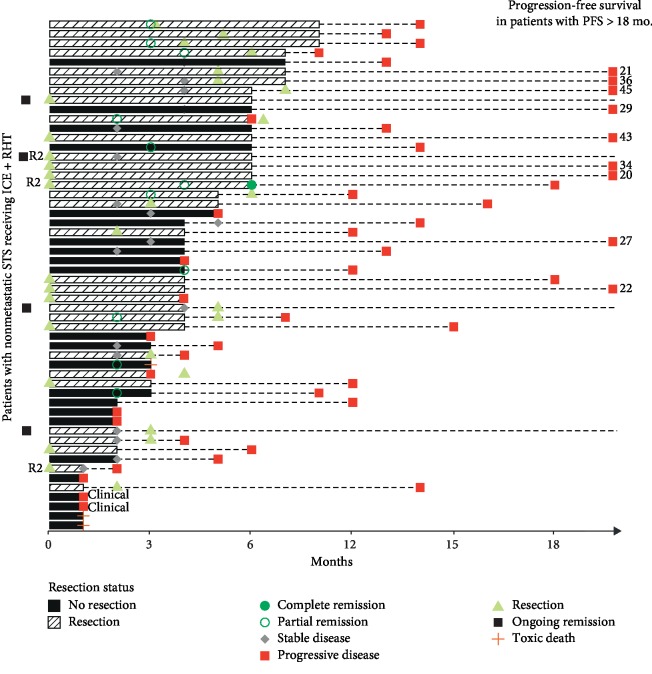
Swimmer plot depicting the clinical course of LA-STS patients (n = 54). Bars represent the treatment duration of ICE + RHT (range: 1–8 months). Results of radiographic assessments and other major clinical events are represented by different symbols, as depicted on the bottom. mo., months and PFS, progression-free survival.